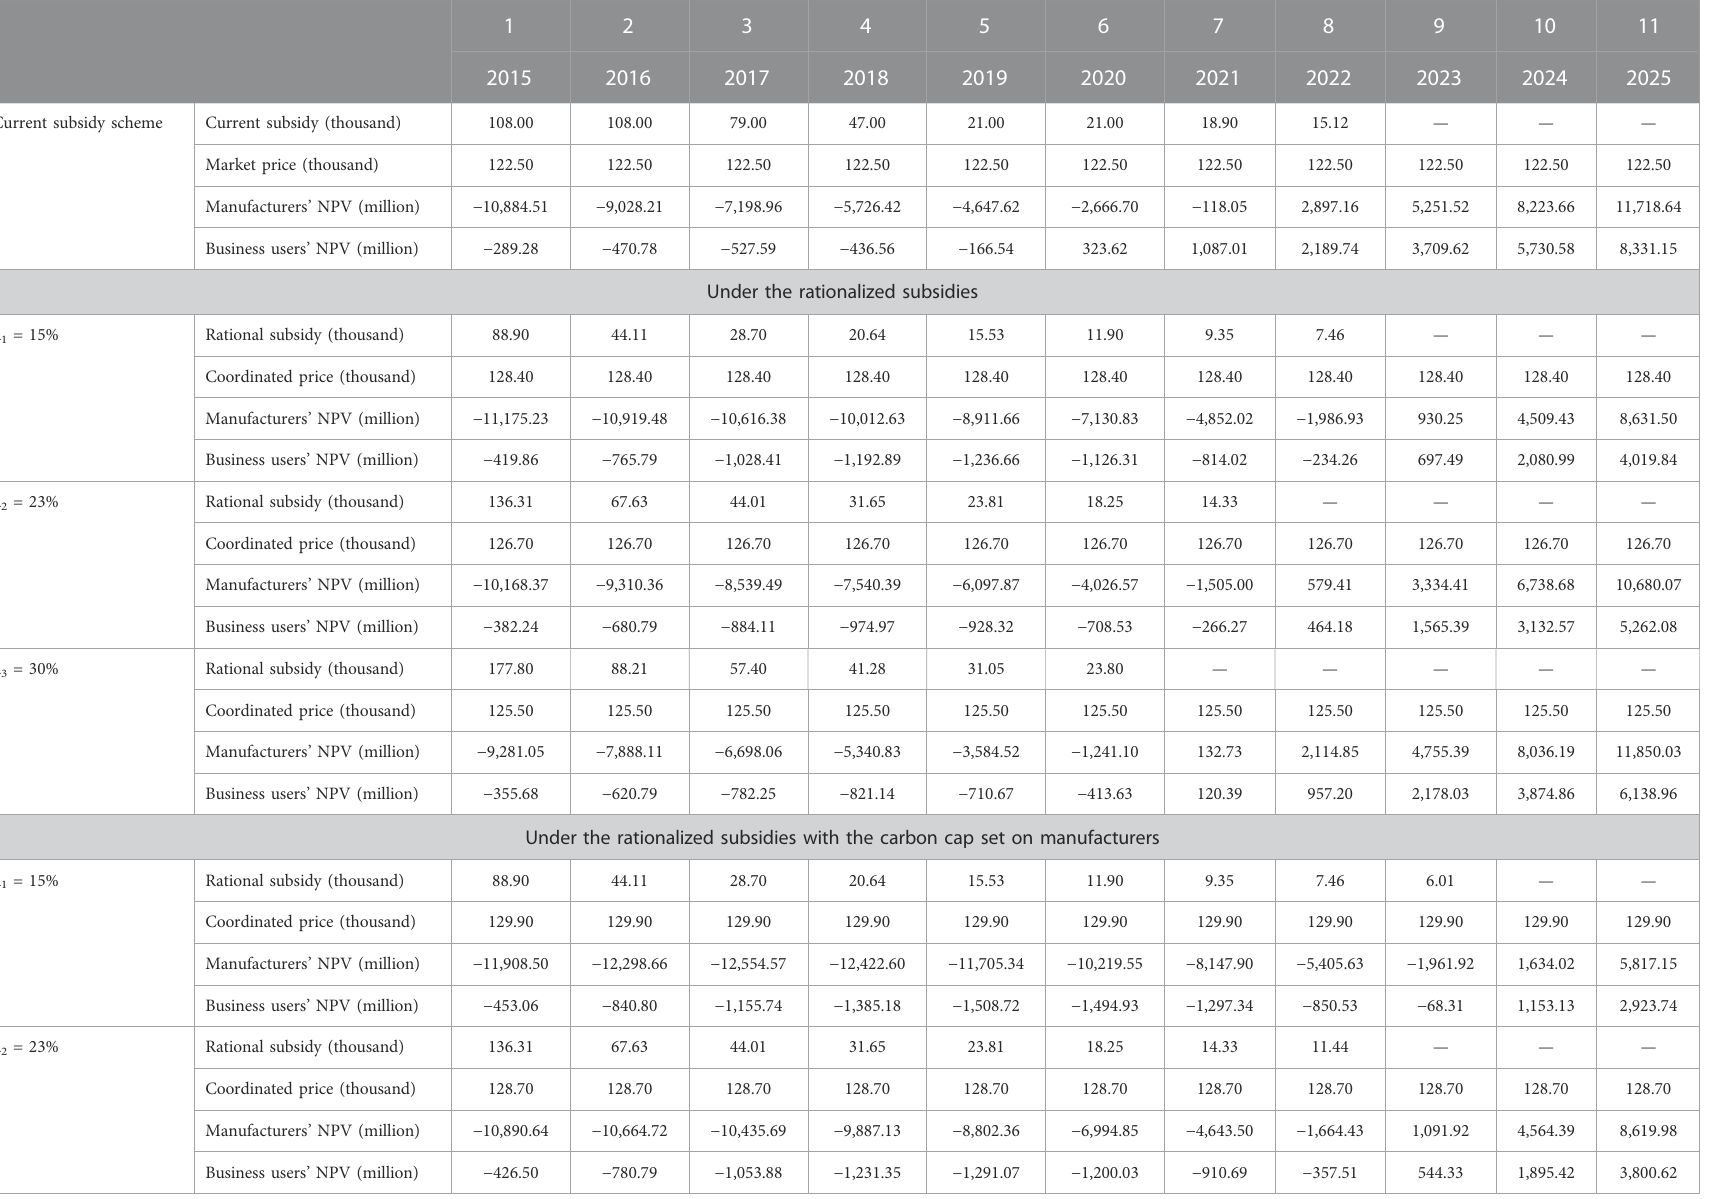
TABLE 4 Results of the NPV break-even of electric vehicles in urban logistics with different subsidy scenarios